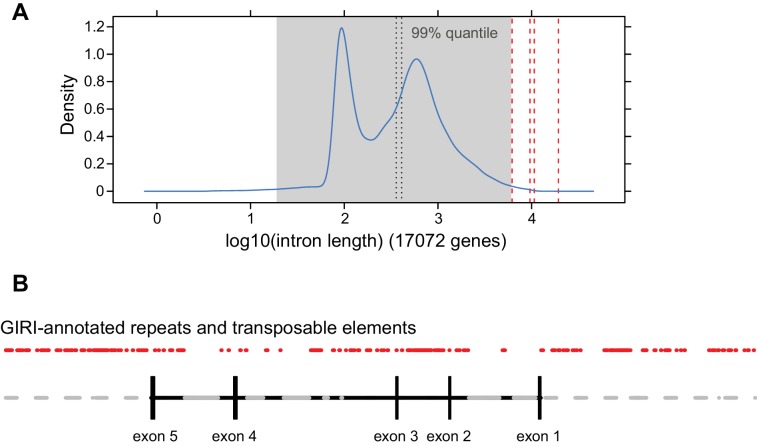
Analysis of CYP734A50 and CYP734A51 introns.(A) Density distribution of intron lengths in the P. veris genome. The four introns of the CYP734A50 locus are indicated by dashed red lines, as is the 99% quantile. CYP734A50 introns range from 6.2 to 19.3 kb, while the mean and median of P. veris intron sizes are 668 and 410 bp, respectively. This difference is significant at p<10–4 based on Wilcoxon rank sum test. (B) Annotation of transposable elements and repeats in CYP734A50 introns from P. veris according to GIRI. Grey areas in introns indicate stretches of unresolved sequences.